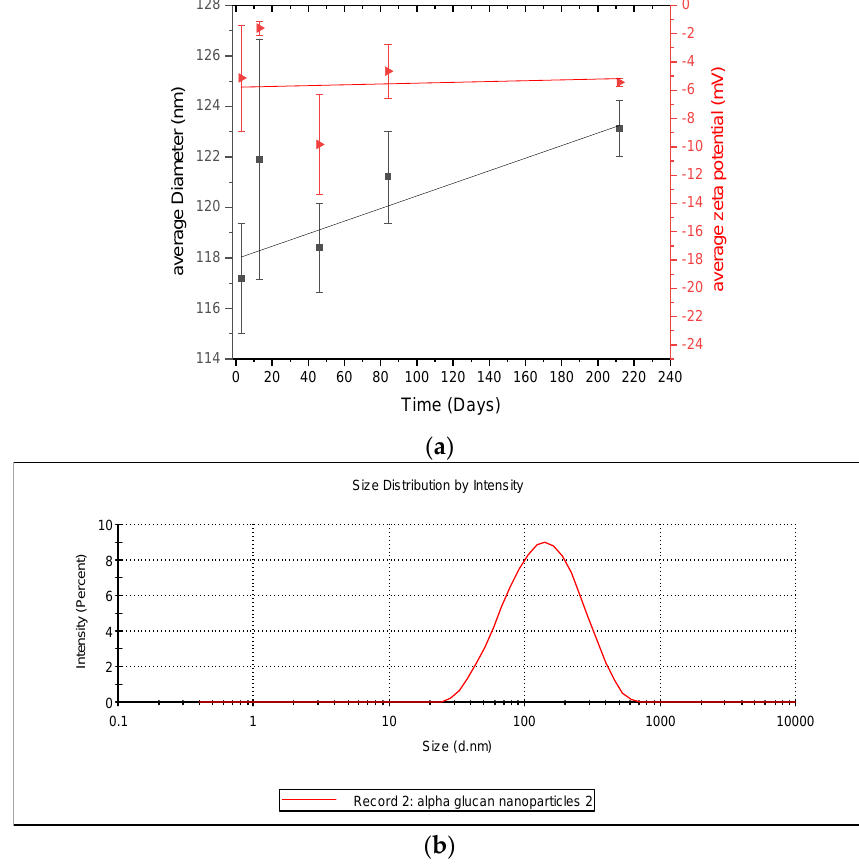
Figure 6. ( a ) Diameter and zeta potential of α -glucan nanoparticles monitored over time; ( b ) representative graph of size distribution of α -glucan nanoparticles during size measurements.